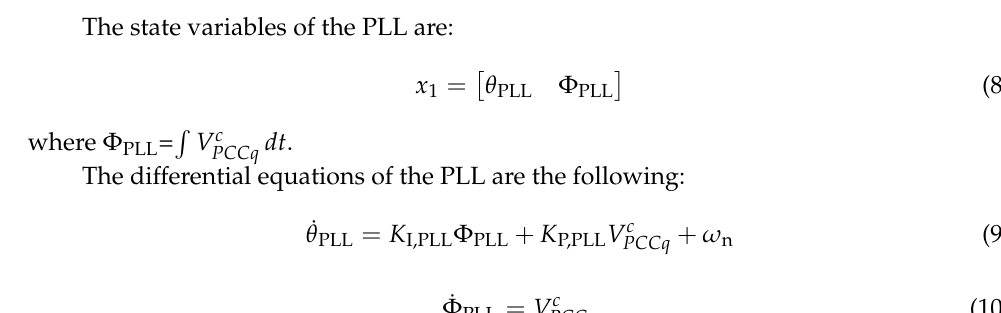
Figure 3. Control structure of the used PLL in Figure